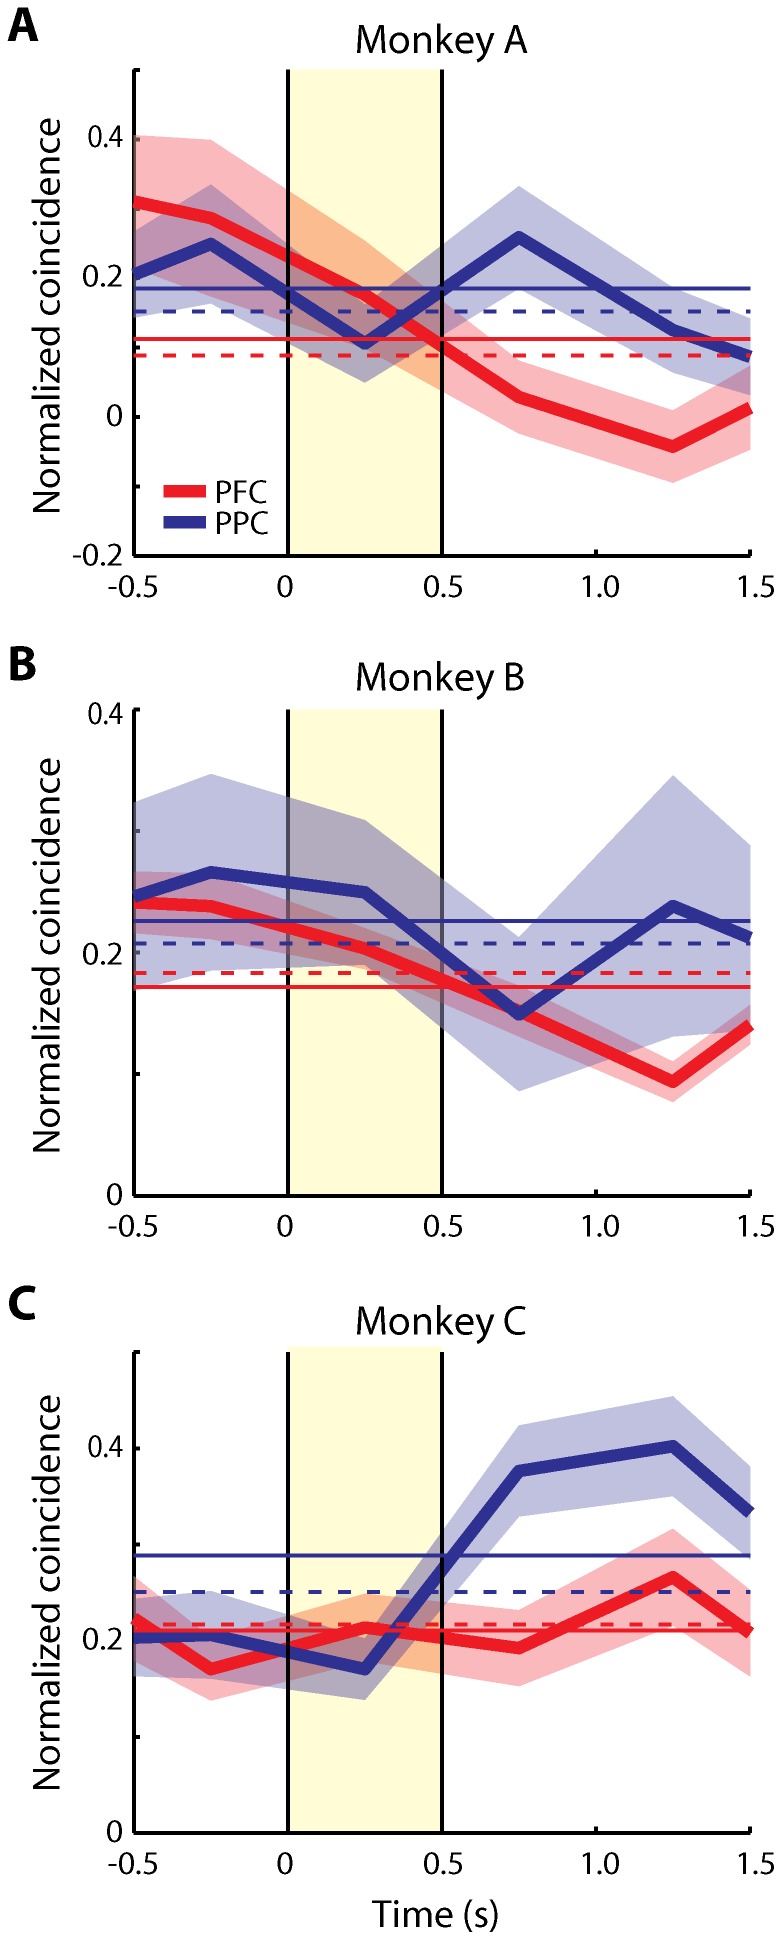
Time course of average effective connectivity for each monkey.Average normalized coincident spikes occurring within the center bin of PSCCHs are plotted for each monkey separately for the dlPFC (red) and the PPC (blue). A) Monkey A (dlPFC: 24 pairs, PPC: 28 pairs). B) Monkey B (dlPFC: 366 pairs, PPC: 46 pairs). C) Monkey C (dlPFC: 171 pairs, PPC: 95 pairs). Samples include all neuron pairs regardless of activity in the delay period. Horizontal bin size is 500 ms. Shaded area along each trace represents one standard error of mean, computed across neuron pairs. The cue presentation period is illustrated by the yellow shaded area. Horizontal solid lines and dotted lines represent a mean over the period up to the first delay period depicted here (–0.5 s to 1.5 s) and a mean over an extended trial period (–0.5 s to 4 s) including the match/non-match period, respectively.